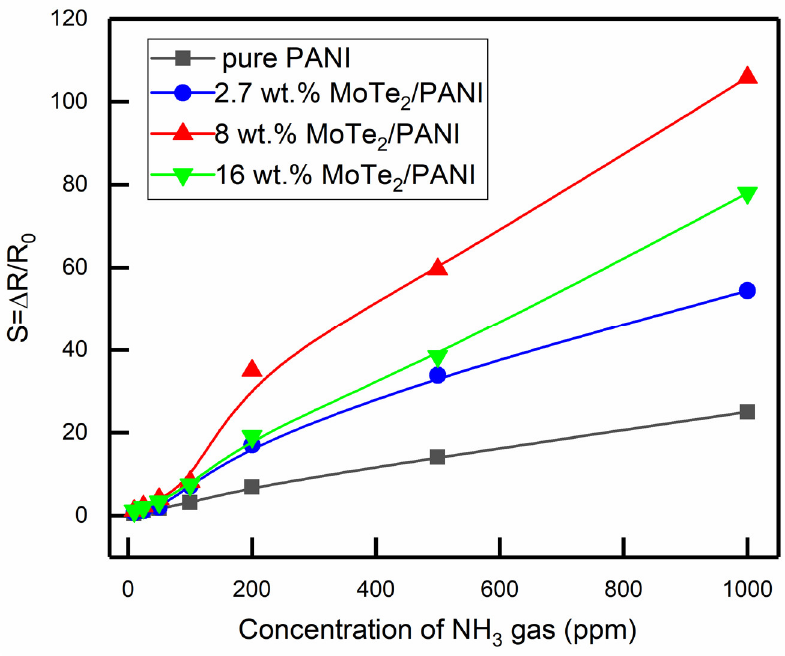
Figure 6. Response of pure PANI sensor and MoTe 2 /PANI composites sensors as a function of NH 3 gas concentration at laboratory environment.